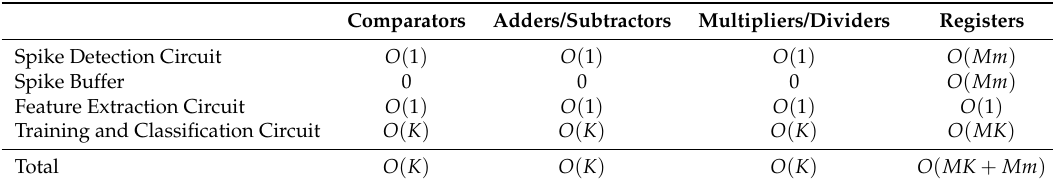
Table 2. The area complexities of the proposed architecture.